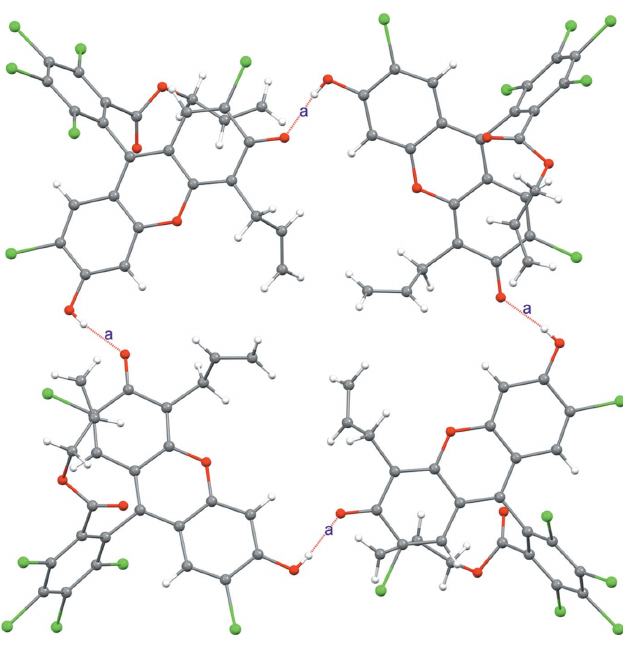
Figure 2 A tetrameric hydrogen-bonded aggregate formed by the title compound: